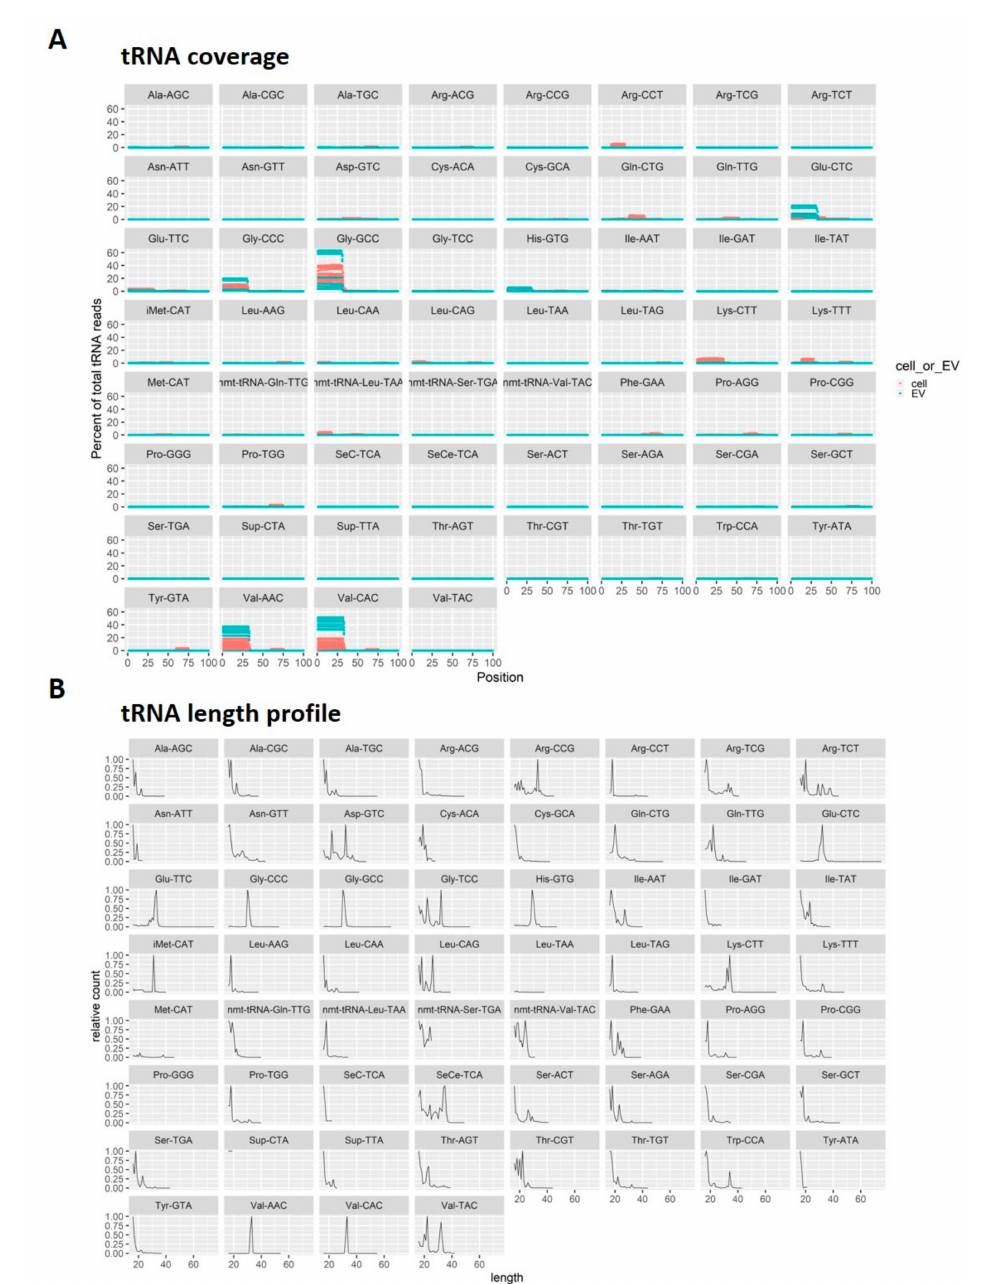
Figure 5. Analysis of small RNAs derived from tRNAs (tsRNAs). ( A ) The coverage position of tsRNAs on the mature tRNAs. (red, cells; green, EVs) ( B ) The length distribution of